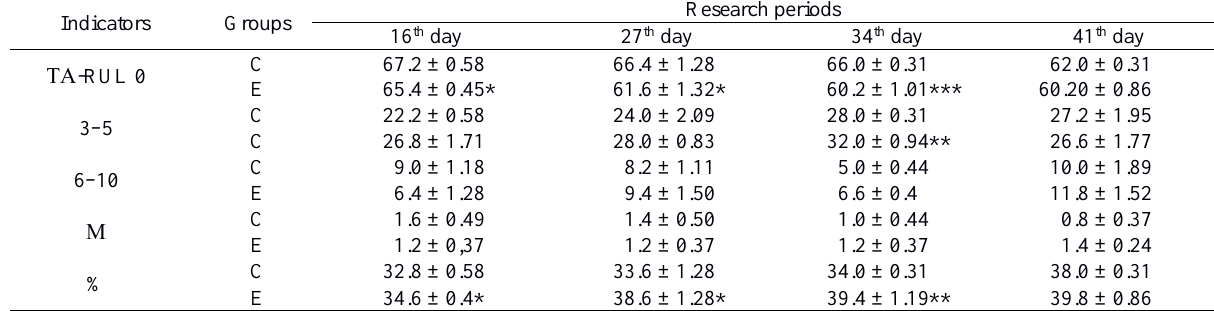
The number of TA-RUL and their functional activity in the blood of broiler chickens, % (M ± m; n = 5) Indicators Groups